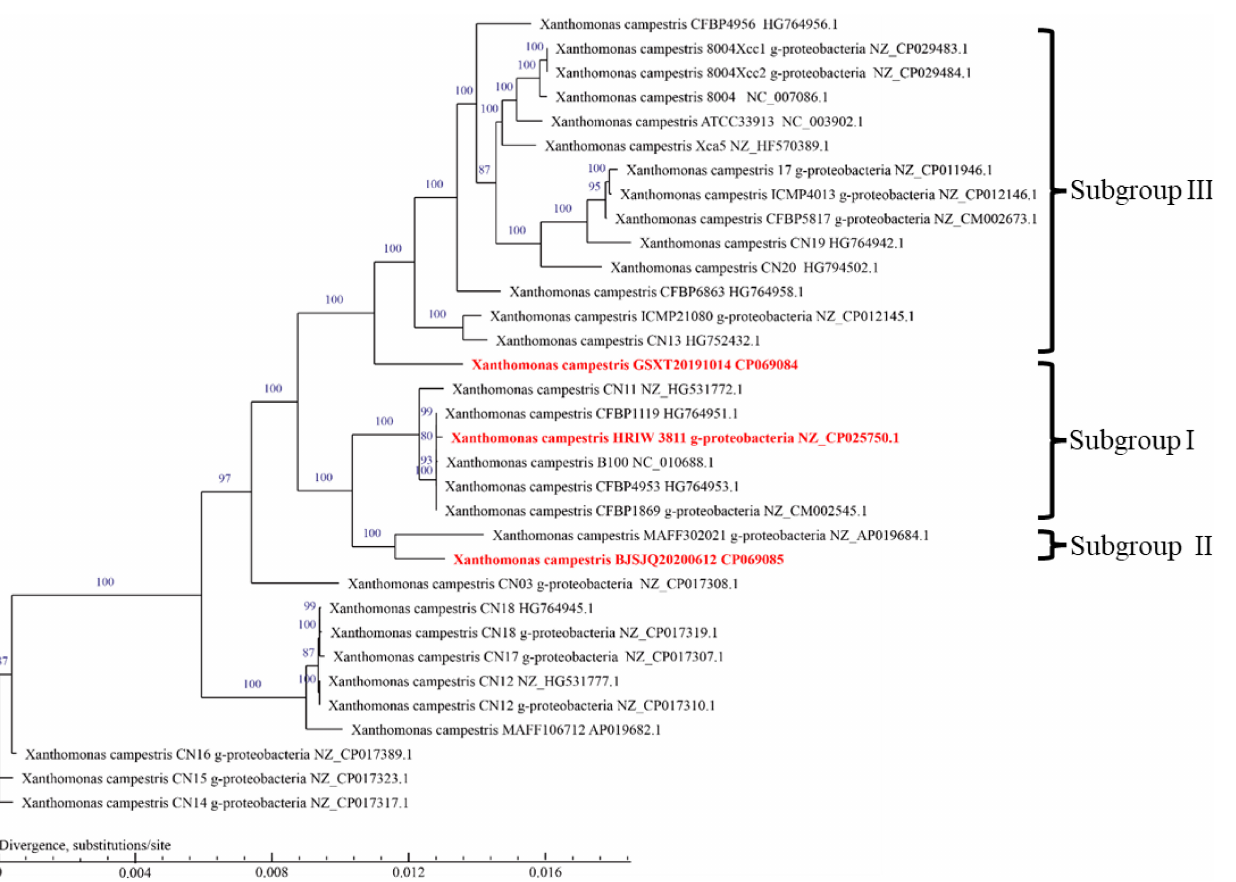
G + C Total genes Predicted Ribosomal Transfer Other Pseudogene (bp) Content (%) no. of CDS RNA (no.) RNA(no.) RNA(no.) (no.)